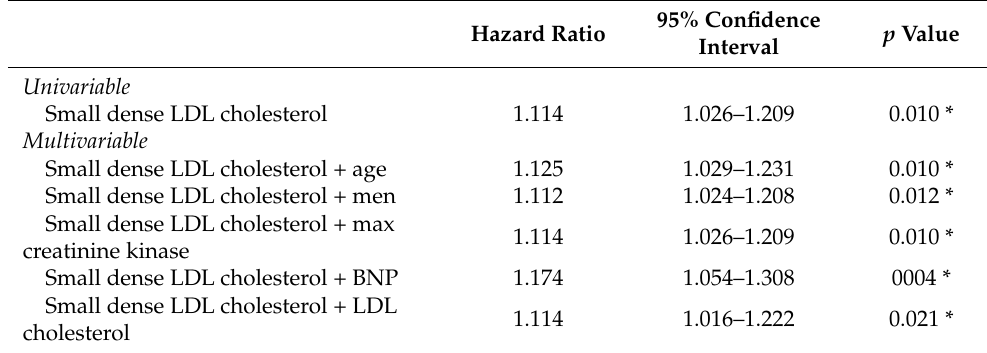
Table 4. Impact of small dense LDL cholesterol at the index discharge upon the primary endpoint. Hazard